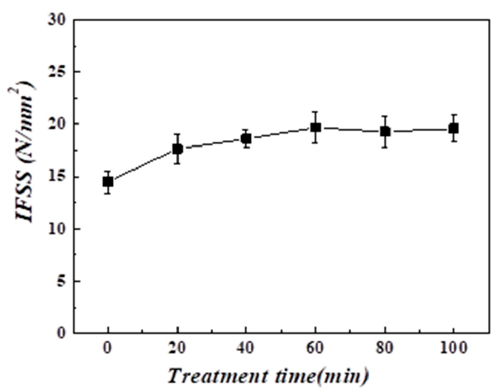
Figure 13. Effect of the acid-treatment time on the interfacial shear strength of the stainless-steel fiber